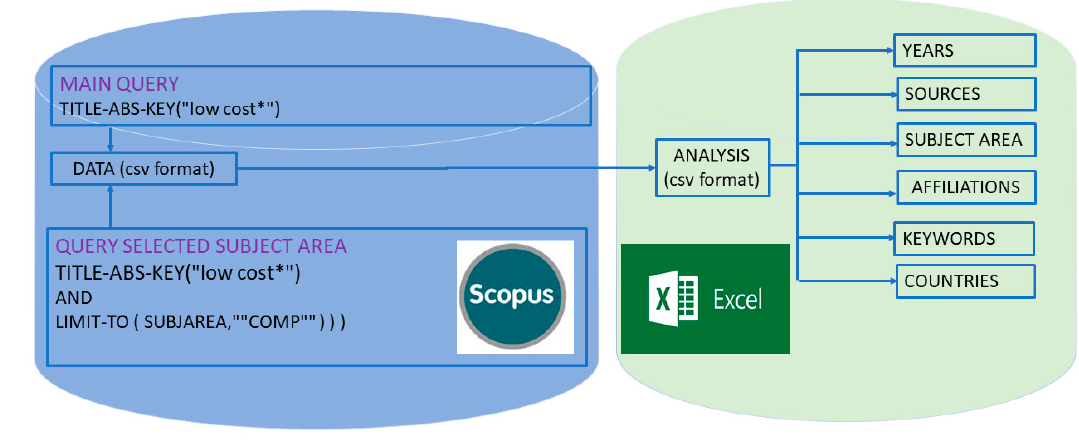
Figure 1. Methodology.